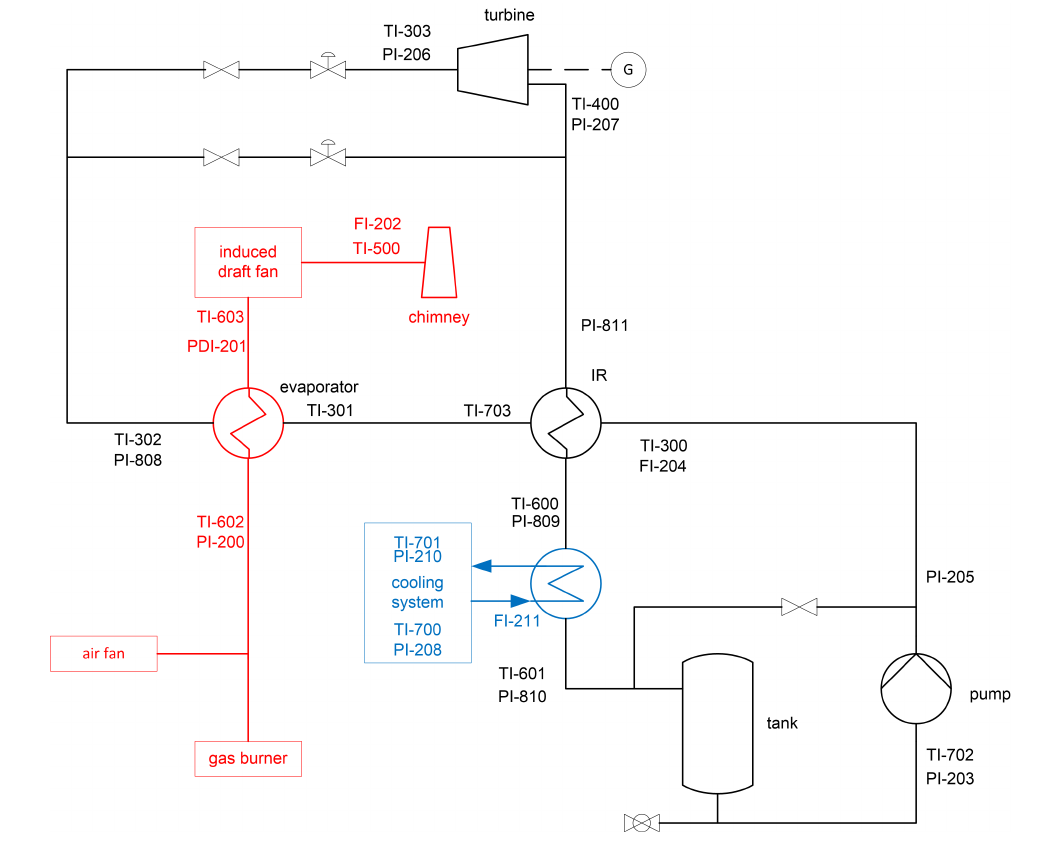
Figure 2. ORC plant layout.